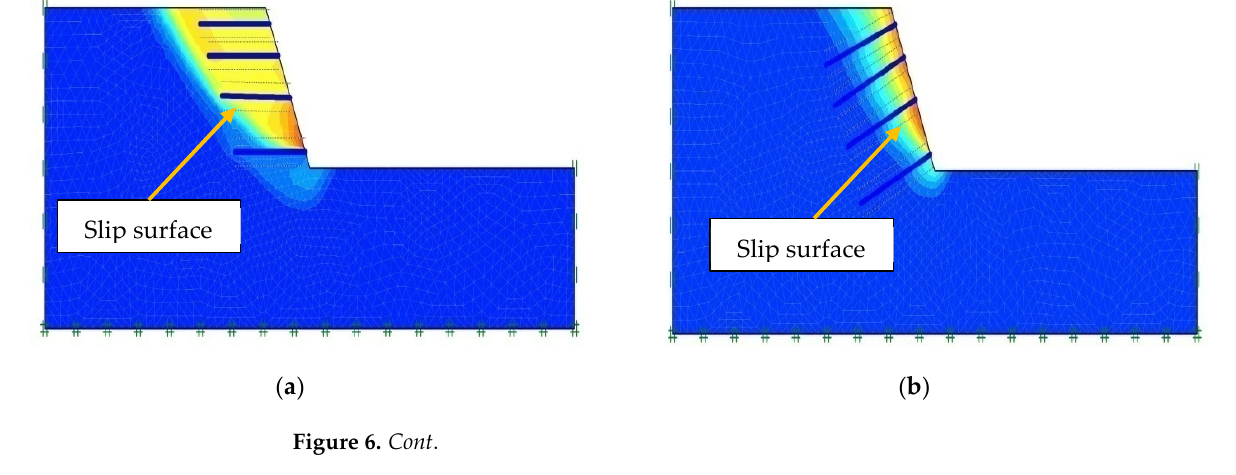
Figure 5. Effect of nail inclination on FS of slopes with different backslope inclinations: ( a ) α = 0°, ( b ) α = 10°, and ( c ) α = 20°.